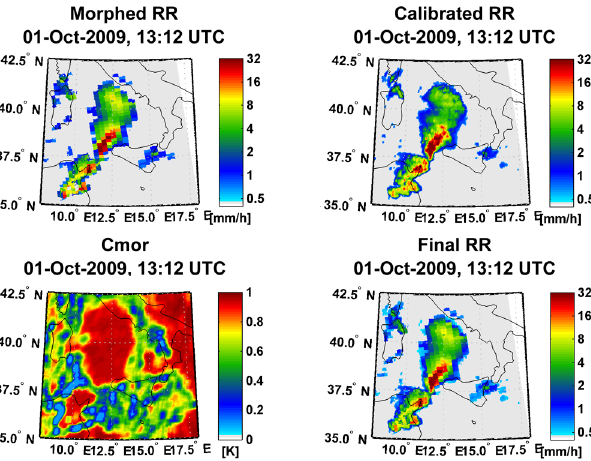
Fig. 4. Example of output of Morphing and Calibration modules, with coefficient matrix C mor used to combine both outputs in final rain-rate map that is the result of first propagation of PET algorithm for event over on southern Italy, 1 October